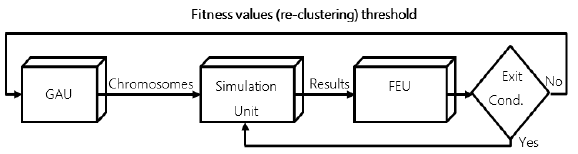
Figure 5. Standard & optimized fuzzy inputs membership functions.